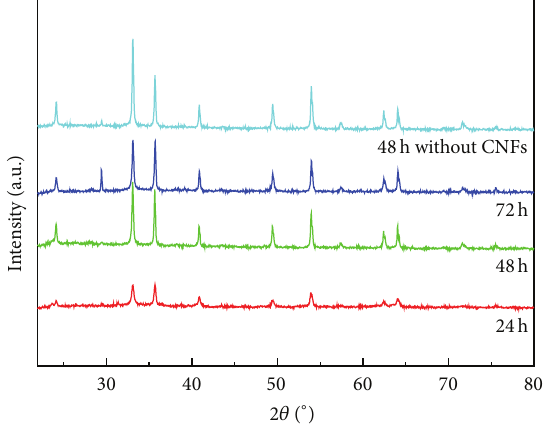
Figure 5: XRD patterns of as-obtained Fe 2 O 3 -CNFs as the function of hydrothermal